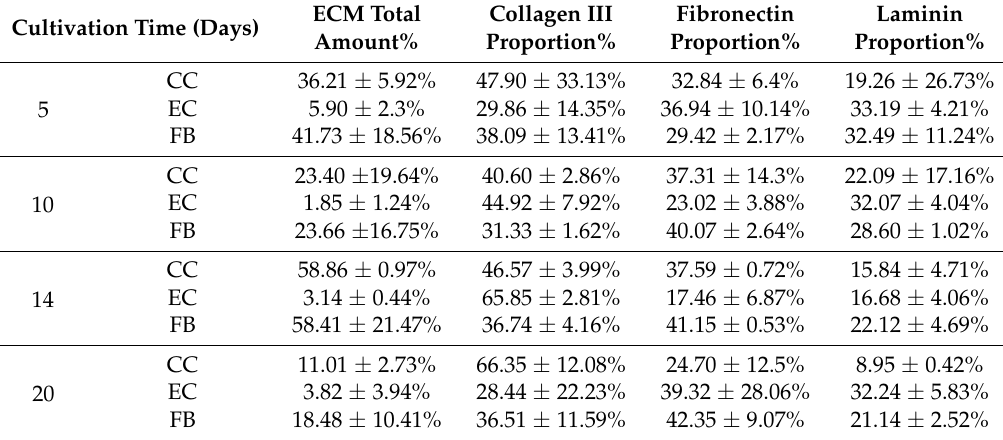
mono cell cultures; FB = fibroblast mono cell